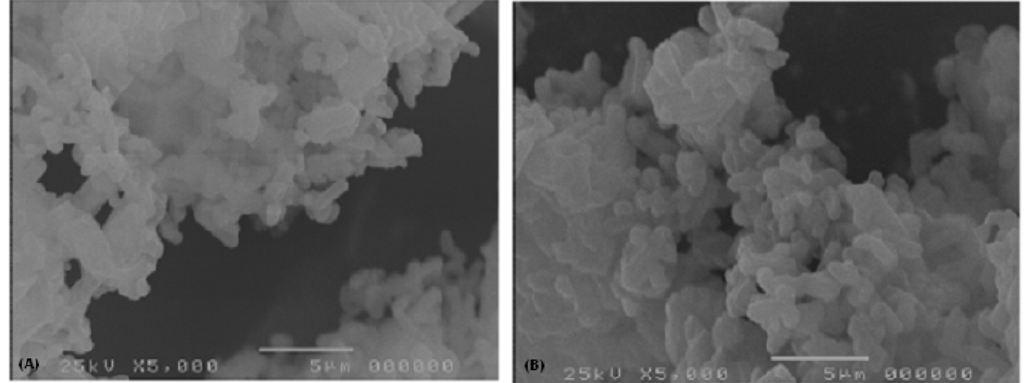
Figure 1 . ( A ) Electron scanning microscopy of batches EFA 5; ( B ) EFA 2 obtained from different micronization procedures.